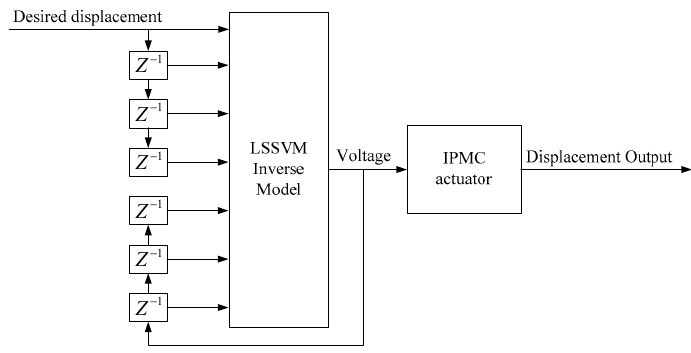
Figure 39. Structure of inverse controller based on the LSSVM ‐ NARX model. Figure 40. Structure of inverse controller based on the LSSVM-NARX